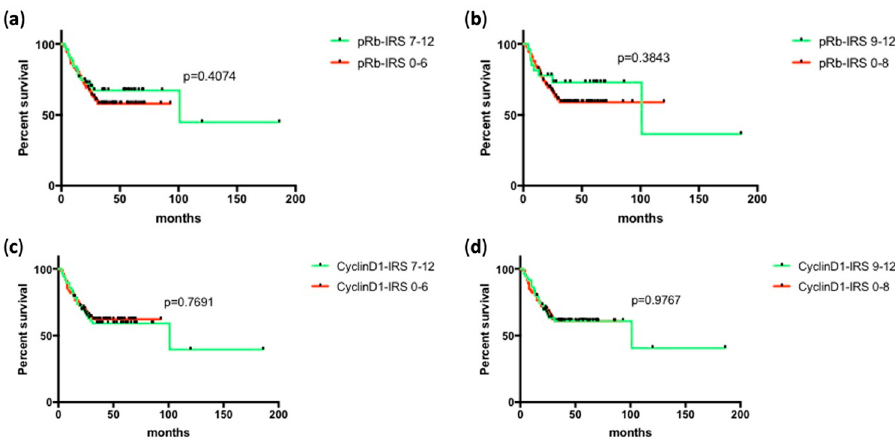
Figure 3. Overall survival of OPSCC patients depending on the expression of pRb and CyclinD1. ( a ) patients with high pRb expression (green, IRS 7-12) vs. low pRb expression (red, IRS 0-6) patients; ( b ) comparison of patients with pRb-IRS 9-12 (green) vs. pRb-IRS 0-8 (red); ( c ) patients with high CyclinD1 expression (green, IRS 7-12) vs. low CyclinD1 expression (red, IRS 0-6); ( d ) comparison of patients with CyclinD1-IRS 9-12 (green) vs. CyclinD1-IRS 0-8 (red). In ( a ) to ( d ), censored data are marked with a black dot. p -values are indicated for each graph (log-rank test). IRS–immunoreactive score.